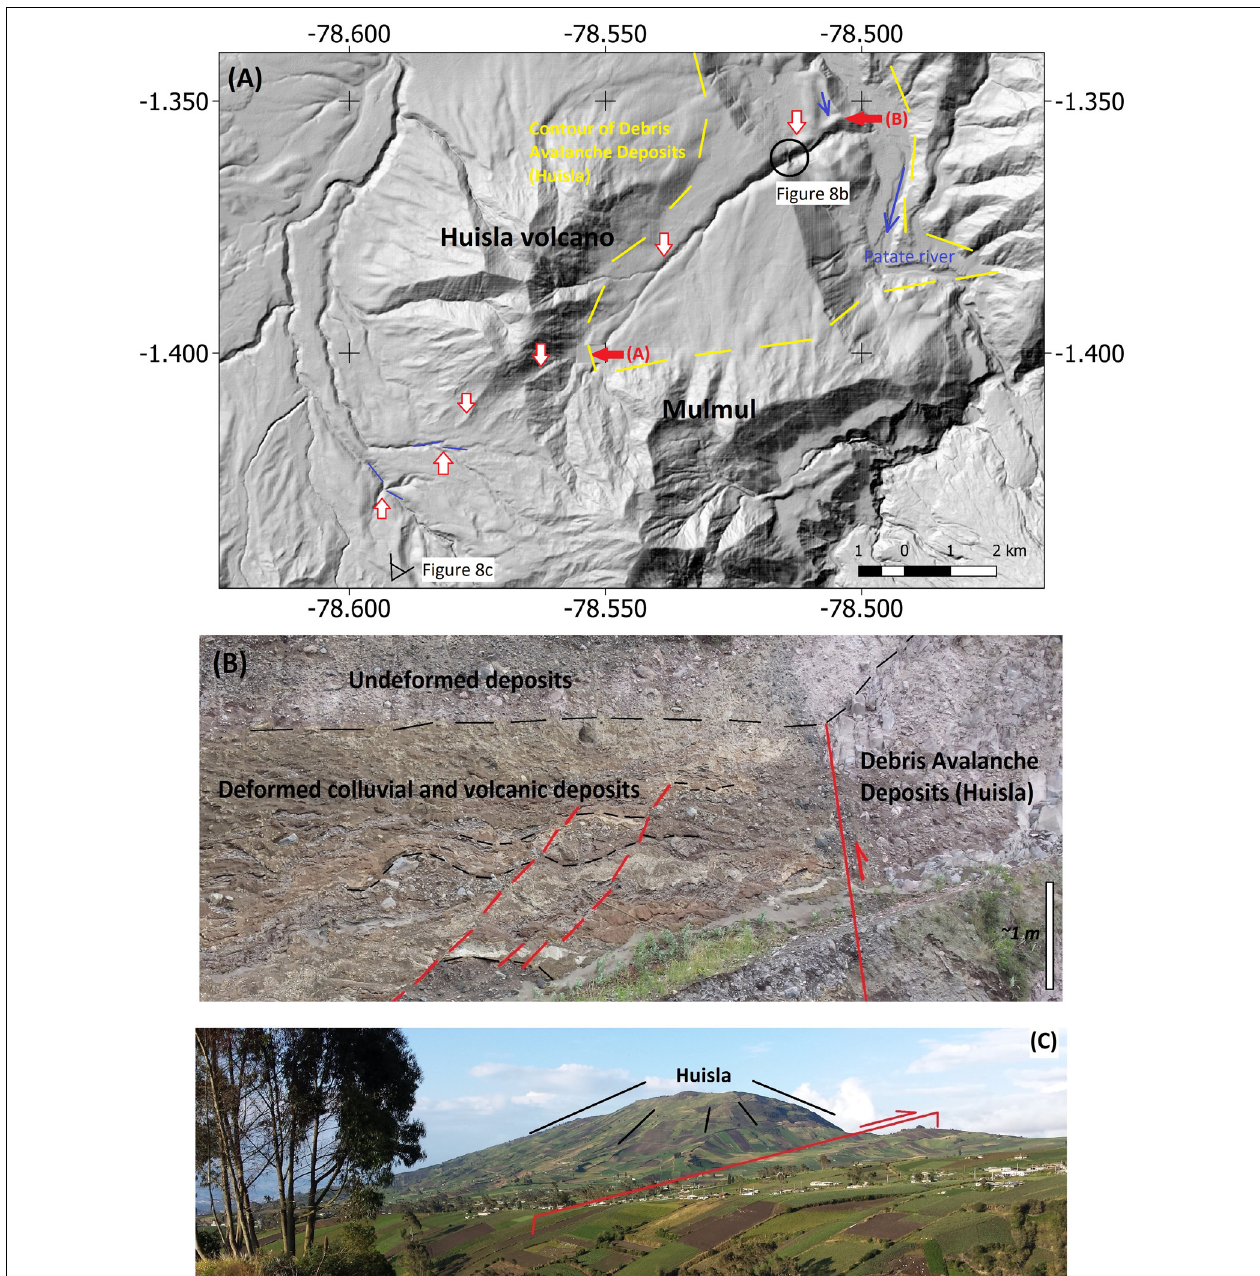
FIGURE 8 | Illustration of the deformation of the Huisla volcano by the fault. (A) The map presents the course of the fault between red arrows, based on its morphological imprint. Southwest of the edifice, several drainage features (yellow dashed lines) are deflected; the fault cuts the southern flank of the Huisla edifice, then the Avalanche Debris of this volcano (emplaced between 215 and 175 ky based on stratigraphical relationships, according to Bablon et al., 2019) and landscape features; A and B labels locate sites described in the text. (B) A road cut exposes the Huisla fault segment juxtaposing the Huisla Avalanche Debris (to the right) with interbedded colluvial and volcanic layers (Pleistocene?). (C) Panoramic view from the south of the Huisla edifice, disrupted by the fault segment; gray lines depict the possible original slopes of the volcano, before its partial collapse and succeeding incision. P.R., Patate River.